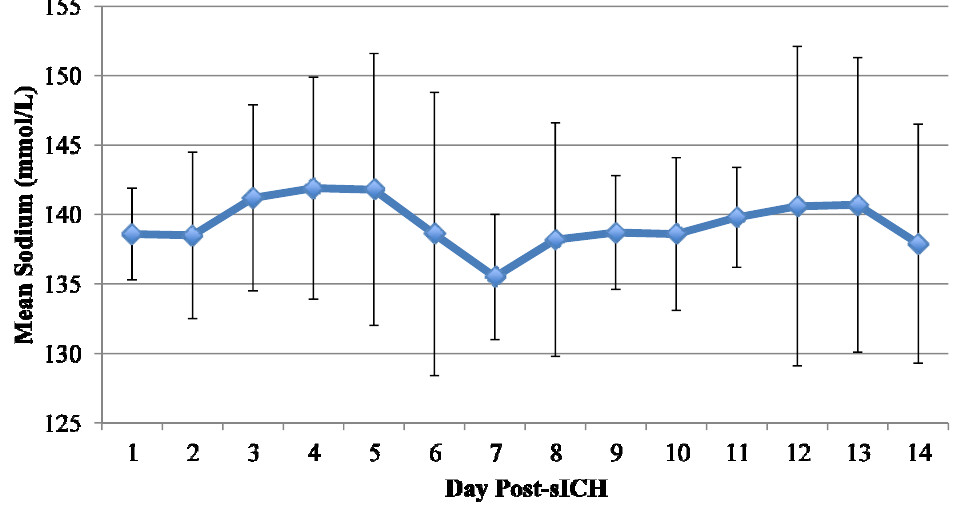
Figure 2. Mean sodium following sICH in patients without